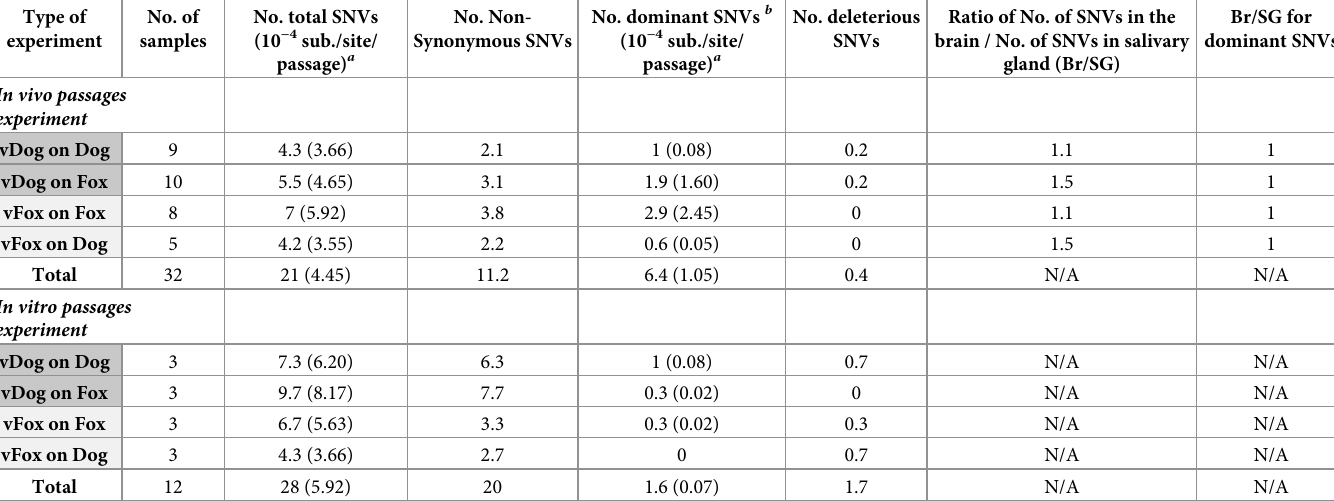
Table 1. Analysis of RABV genetic variation in intra- and inter-host comparisons and in specific organs. Type of